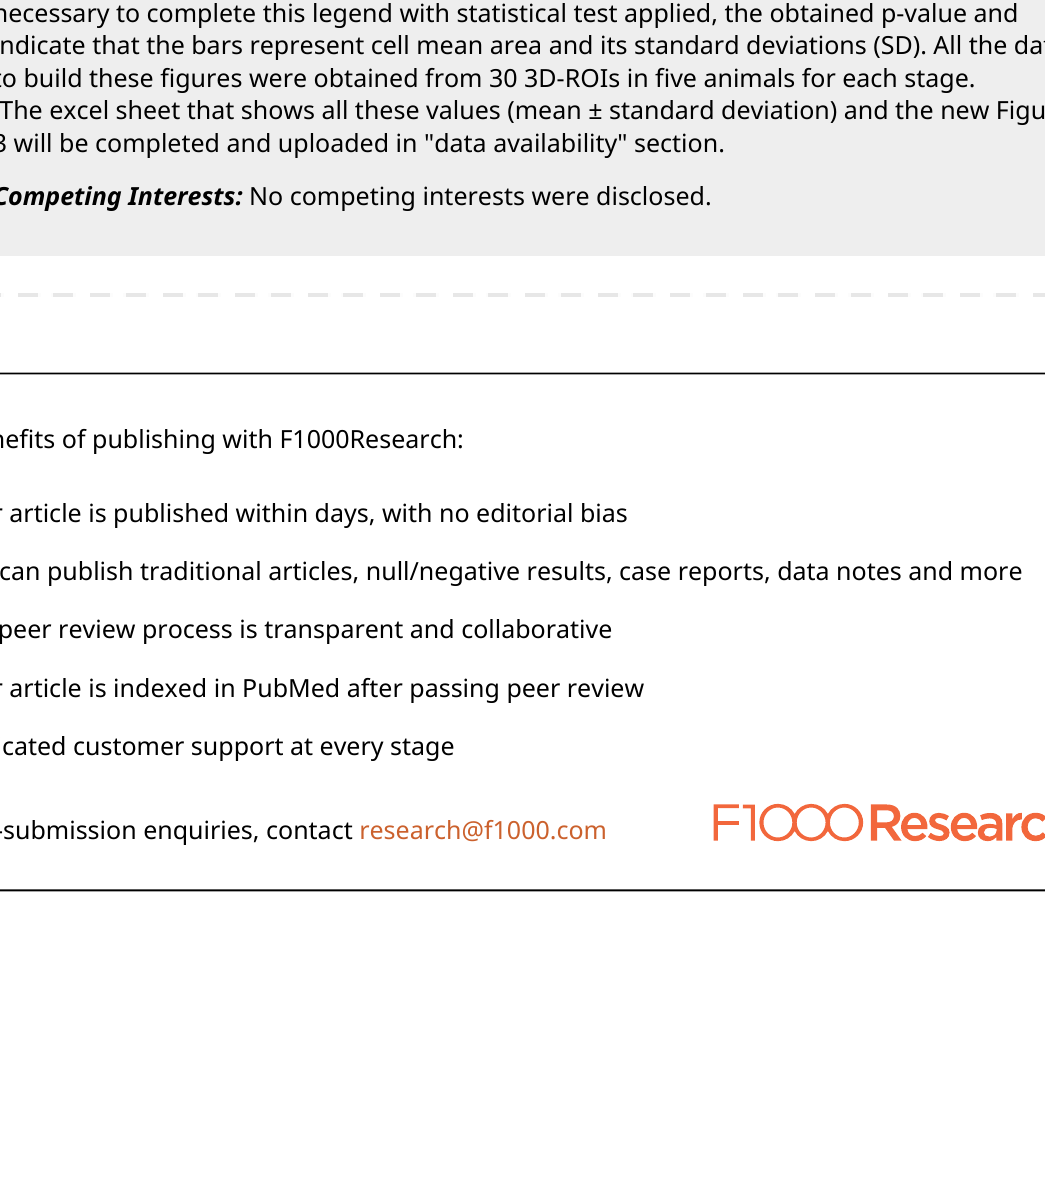
MFS: It will be necessary to modify the legend of this figure, specifying that Figure 3a corresponds to a bar graph displaying mean percentages of x-sided polygons of embryos at 24 hpf (n = 81 cells), 31 hpf (n = 147 cells), 48 hpf (n = 133 cells) and 72 hpf (n = 102 cells). The bars will represent mean values with their standard deviations. The type of statistical analysis performed on the data and the p-value obtained will be specified. MFS: Regarding Figure 3b this shows the mean area of cell types at 24 hpf (EVL n = 73), 31 hpf (EVL n = 147), 48 hpf (EVL n = 133) and 72 hpf (EVL n = 102). In the same way, it will be necessary to complete this legend with statistical test applied, the obtained p-value and indicate that the bars represent cell mean area and its standard deviations (SD). All the data to build these figures were obtained from 30 3D-ROIs in five animals for each stage. The excel sheet that shows all these values (mean ± standard deviation) and the new Figure 3 will be completed and uploaded in "data availability"